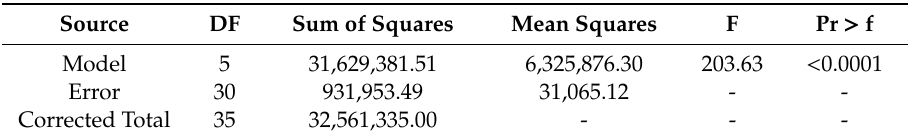
Table 4. Analysis of variance. Dynamic modulus.